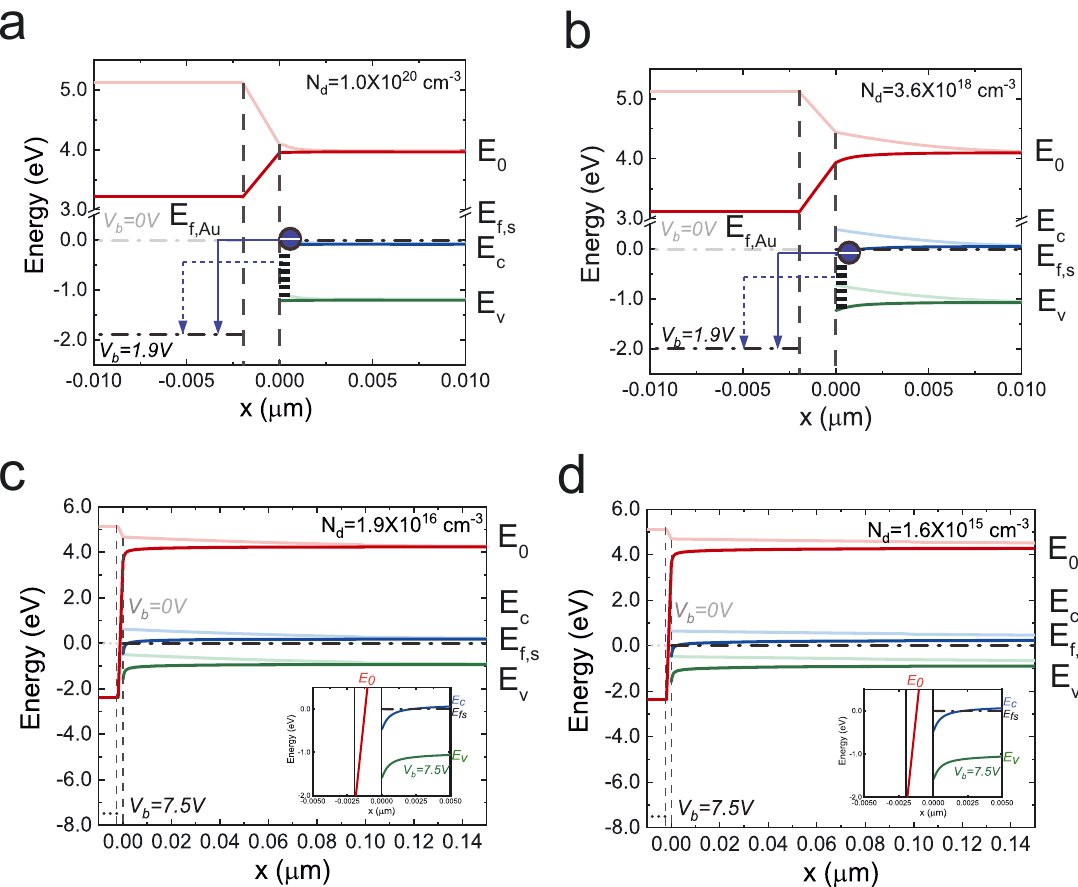
Figure 5: Energy band diagrams of Au/SiO 2 /n-Si junctions at different voltage bias (faint line for the vacuum level is for V b = 0, red line is for the higher voltage) (a) 1.0 × 10 20 cm − 3 , (b) 3.6 × 10 18 cm − 3 , (c) 1.9 × 10 16 cm − 3 , (d) 1.6 × 10 15 cm − 3 in n-Si. The insets of c and d are the zoom-in at the interface of SiO 2